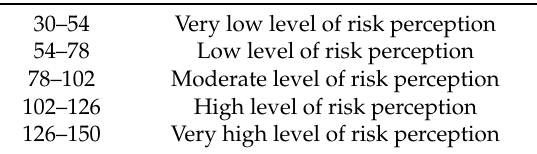
Table 4. Interpretation of risk perception level